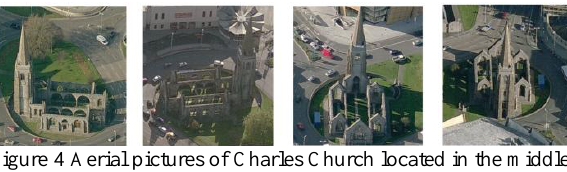
Figure 4 Aerial pictures of Charles Church located in the middle of a roundabout. Source of images: